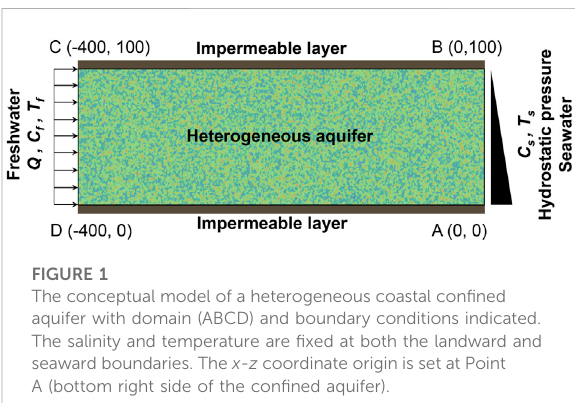
FIGURE 1 The conceptual model of a heterogeneous coastal con fi ned aquifer with domain (ABCD) and boundary conditions indicated. The salinity and temperature are fi xed at both the landward and seaward boundaries. The x - z coordinate origin is set at Point A (bottom right side of the con fi ned